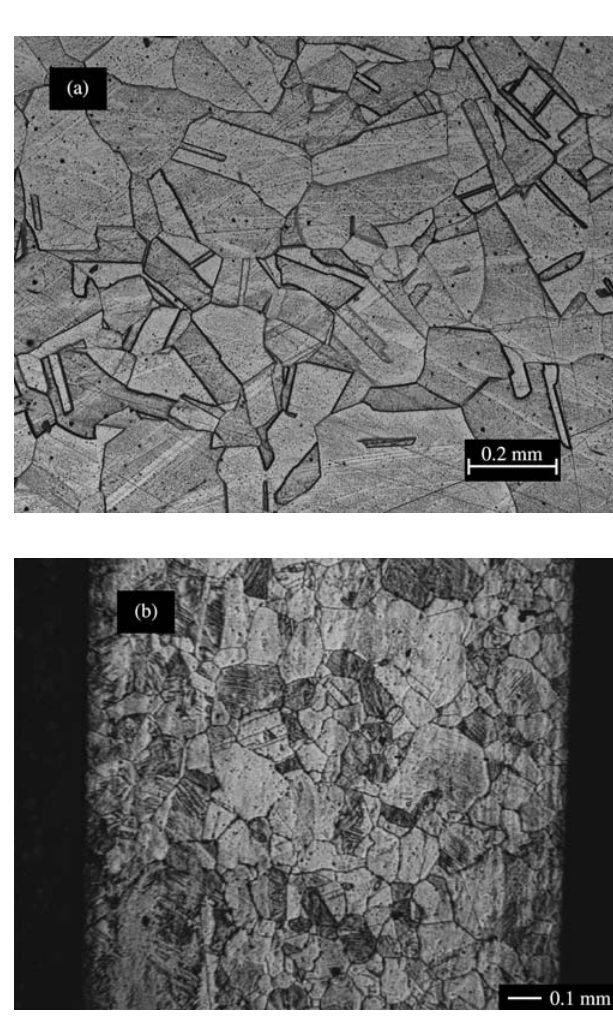
Figure 5. a) Annealed austenitic steel microstructure; and b) austenite with martensite formation after fatigue